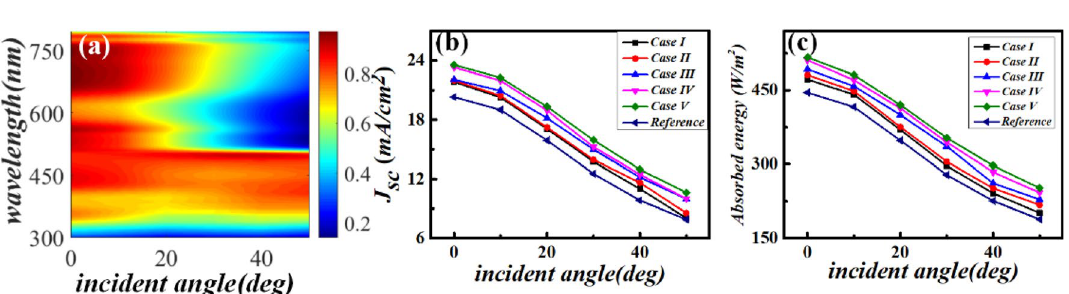
Figure 9. Incident angle-dependent optical properties of the proposed solar cells. ( a ) 2D map of the calculated incident angle-dependent absorption efficiency of the optimized case V. ( b and c ) Comparison between the incident angle-dependent optimized J sc ( b ) and absorbed energy ( c ) of the five proposed solar cells and